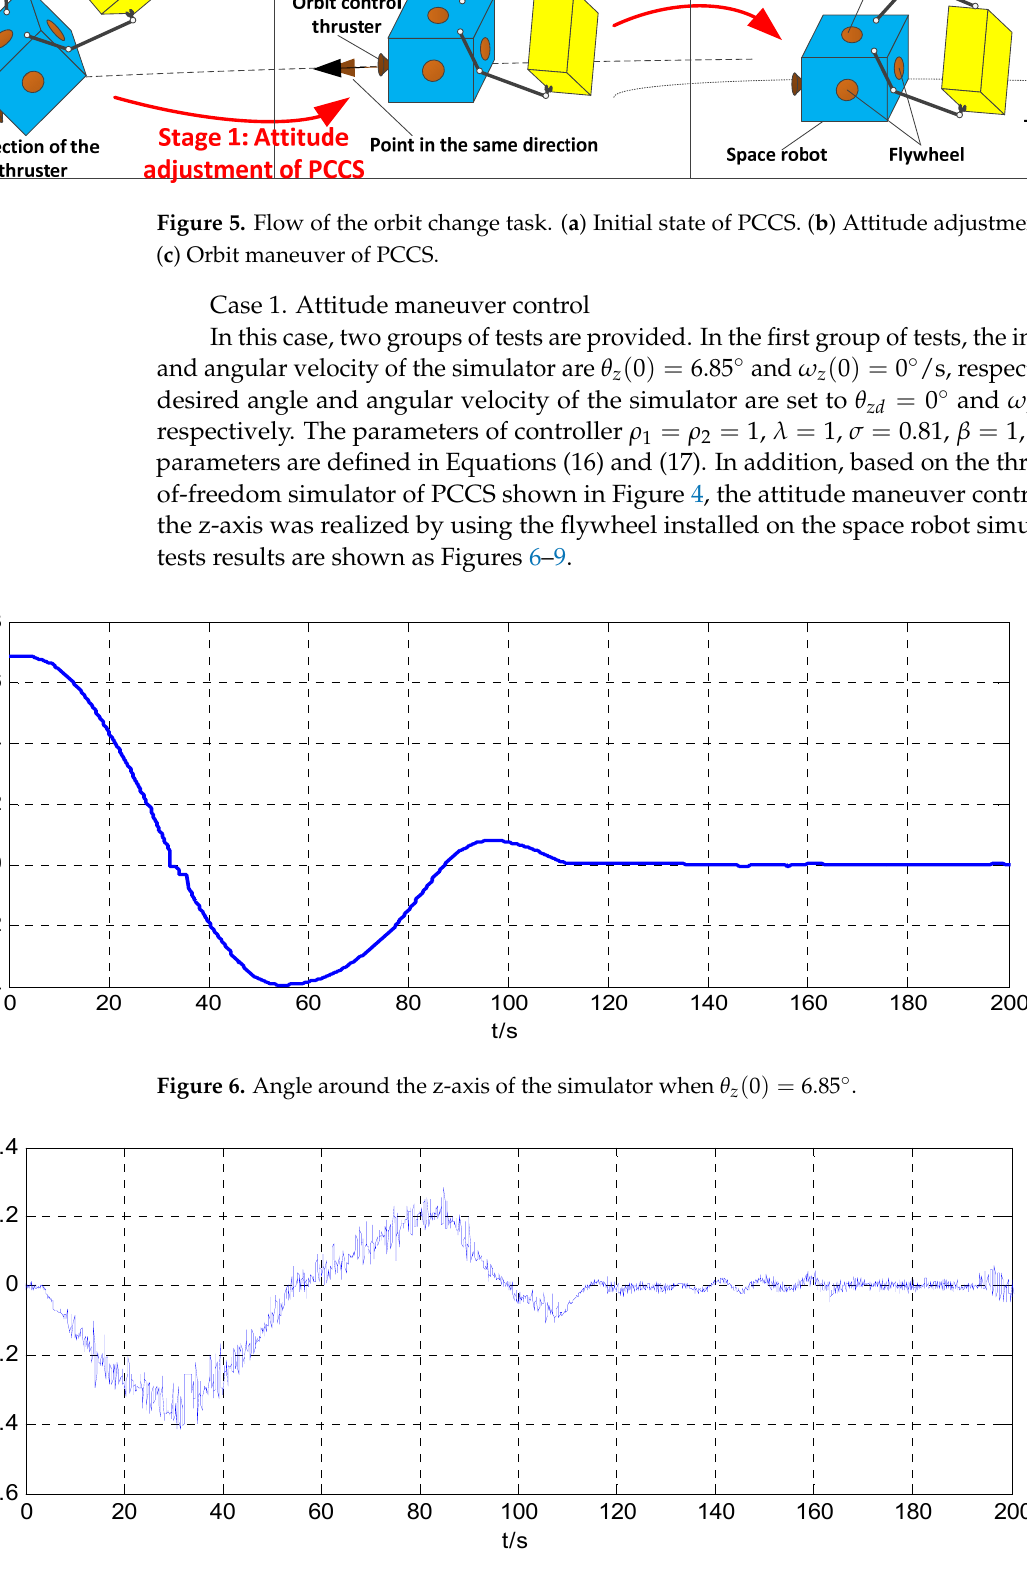
Figure 7. Angular velocity around the z-axis of the simulator when θ z ( 0 ) = 6.85 ◦